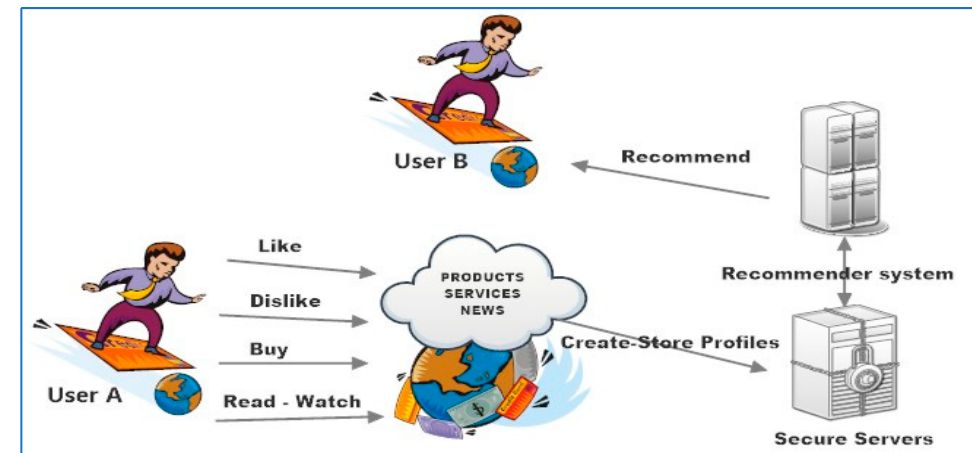
Figure 1. Recommendation system.